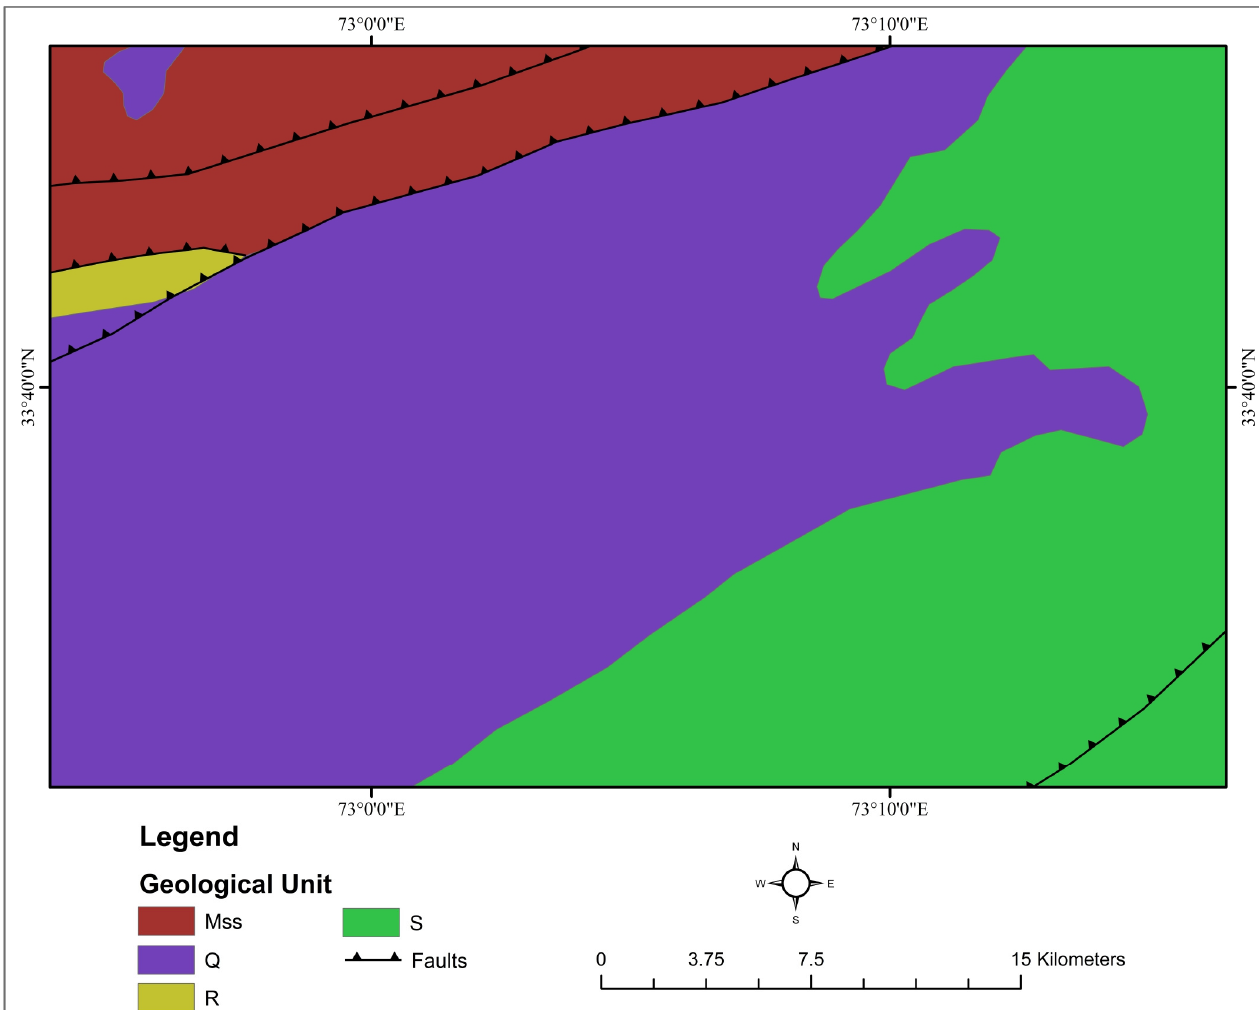
Figure 3. Geological formations in the investigated area. Mss: Mesozoic sedimentary rocks, R: Ra- walpindi group, S: Siwalik group, Q: Quaternary